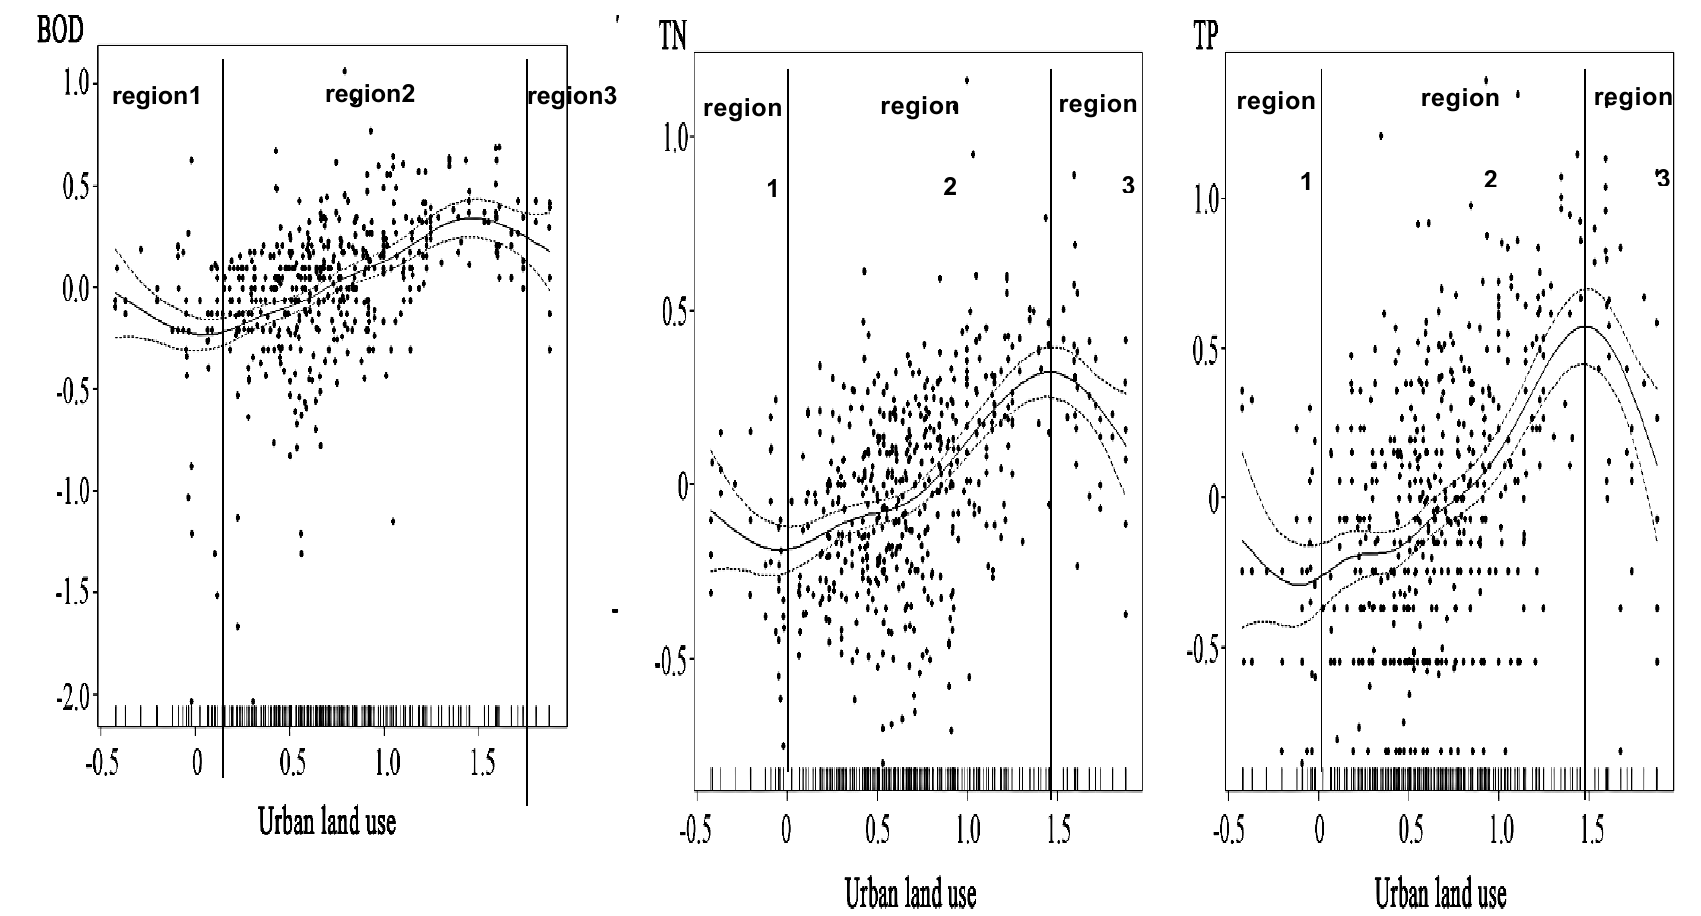
Figure 3. Regionalized zones in the non-linear relationships between urban land use and biological oxygen demand (BOD), total nitrogen (TN), and total phosphorous (TP) in streams. All variables were log-transformed.